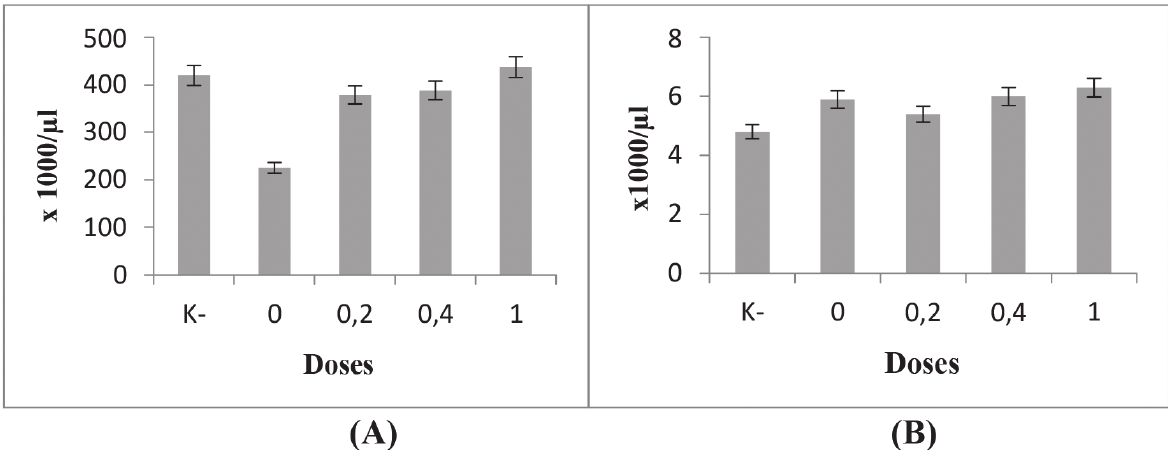
Figure 4. A . Platelet Count Between Treatment Groups Mice Infected with DENV-2 + CA Concentration of 0, 0.2, 0.4, and 1 g/kg BW B . Number of Leukocytes Between Treatment Groups Mice Infected with DENV-2 + CA Concentration of 0, 0.2, 0.4, and 1 g/kg